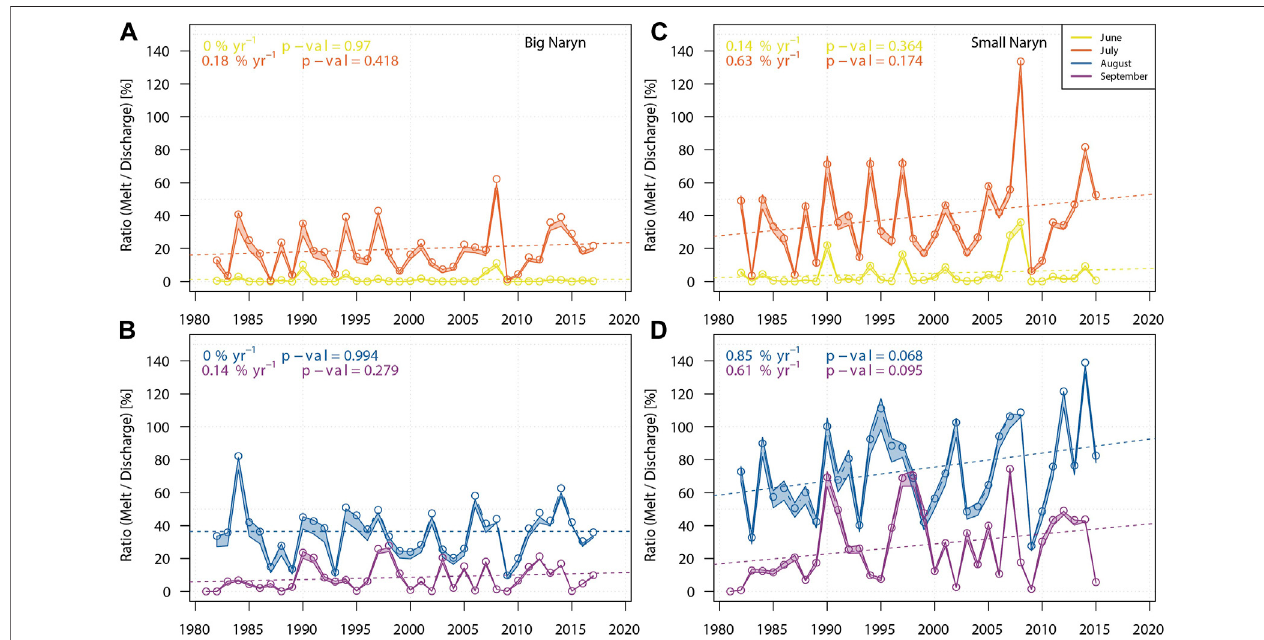
FIGURE 8 | Mean measured runoff and modelled glacier melt comparison for (A) June and July, (B) August and September for the Small Naryn and (C) June and July, (D) August and September for Big Naryn